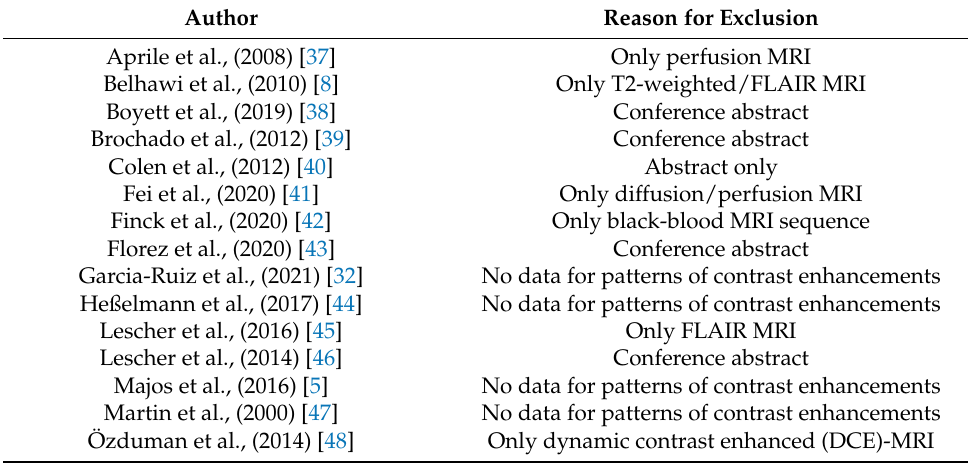
Table A1. Reasons for exclusions after full-text assessment.